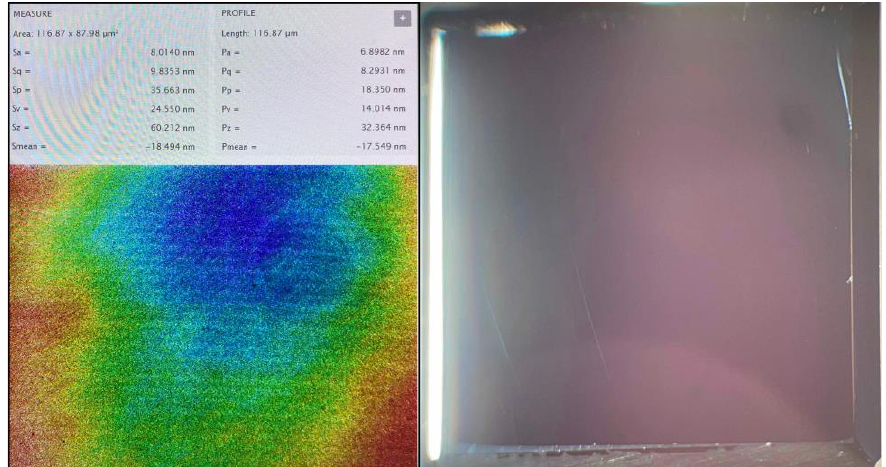
Figure 2. Parameters of polish quality. Left - image from profilometer, right - image from optical microscope.